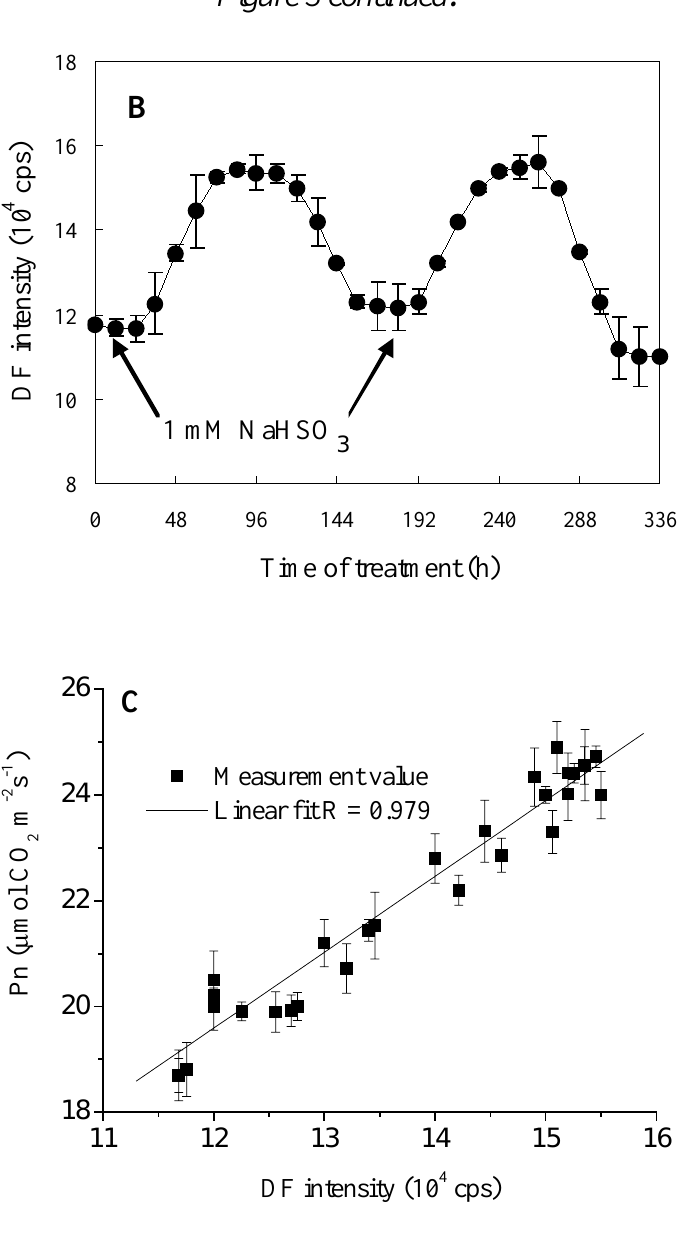
Figure 5. Temporal profile of DF intensity (A) and Pn (B) of leaves of soybean ( Glycine max Zaoshu No. 18) seedlings with 1 mM NaHSO treatment and the relationship between DF intensity and Pn (C). 3 Arrow indicates the time for spraying NaHSO . In the figure each value is the mean ± S.E. of nine 3 independent